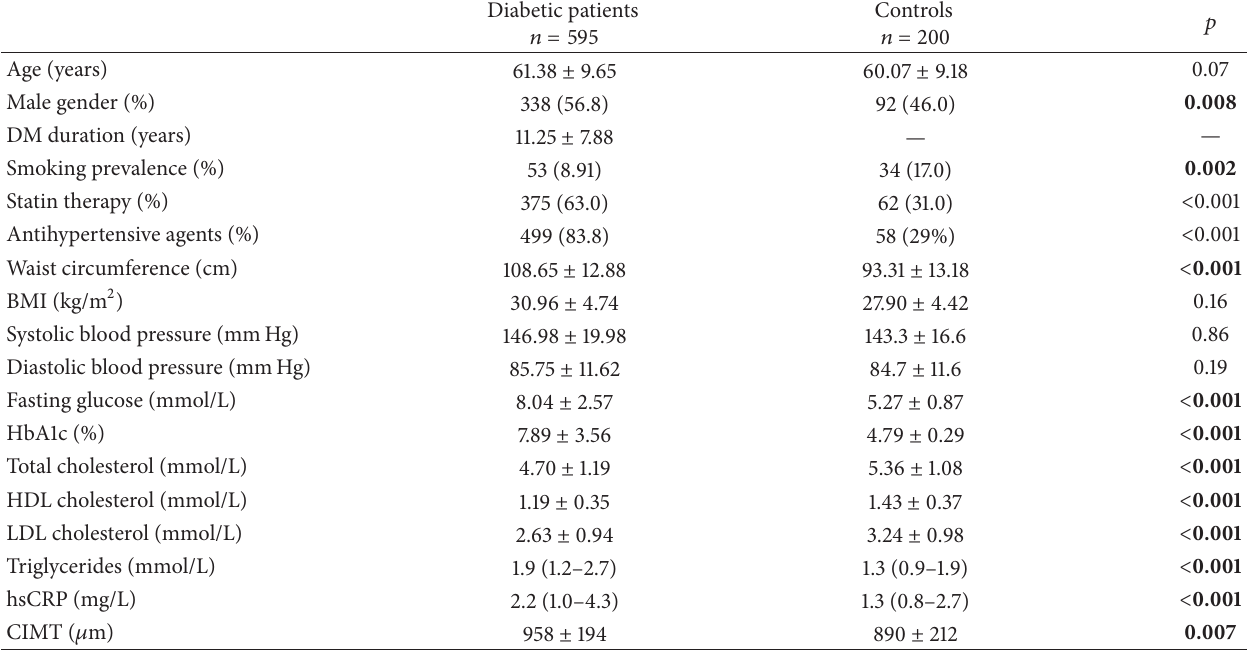
Table 1: Baseline clinical and biochemical characteristics of diabetic patients and controls.